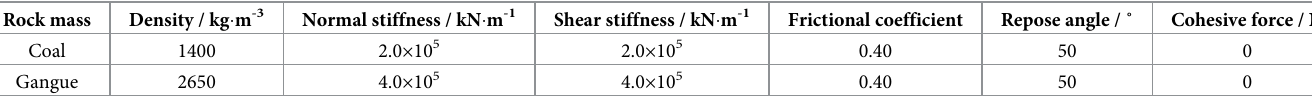
Table 1. Physical parameters of coal and